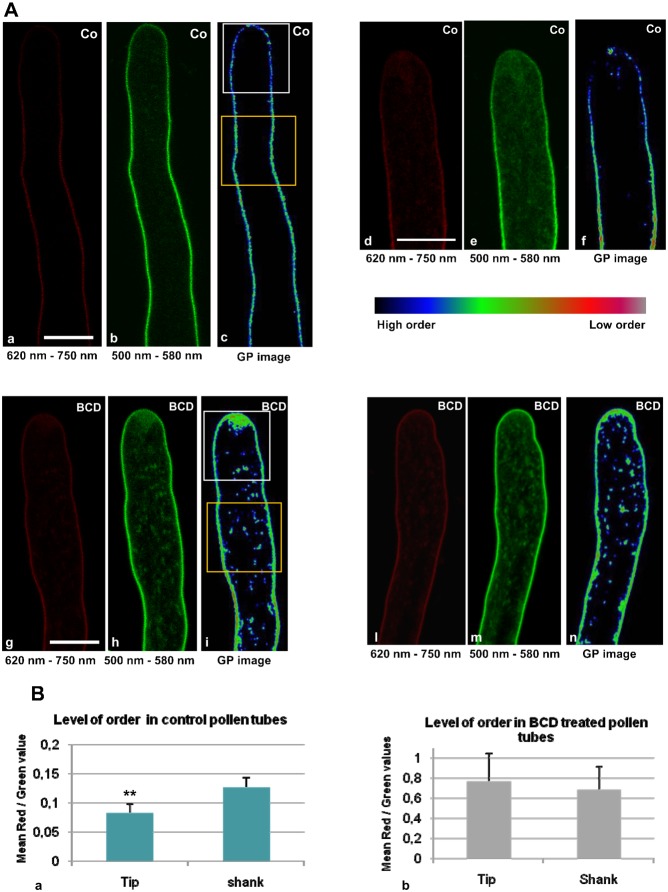
Ratiometric live imaging of di-4-ANEPPDHQ in growing pollen tubes.(A) Higher and lower membrane order distribution in control and BCD treated pollen tubes. (a–f) Red (a,d) and green (b,e) channels of control pollen tubes. GP images (c,f) revealed a higher membrane order in the tip region than in the shank. (g–i,l–n) In BCD-treated pollen tubes both the red (g,l) and green (h,m) channel intensities were uniform in tip and shank. GP images (i,n) showed loss of asymmetry in higher-order membrane distribution along pollen tube. Scale bars: 10 µm. (B) Ratio of ratios. (a) Red/green values calculated in the tip (white ROI) and shank (yellow ROI) of control pollen tubes. The mean red/green ratio in the tip was significantly lower than in the shank (n = 12). (b) Red/green ratios in the tip (white ROI) and shank (yellow ROI) of BCD-treated pollen tubes. Mean red/green ratios in tip and shank were equal and higher than in controls (n = 9). Error bars indicate standard errors. ** indicates P<0.001.